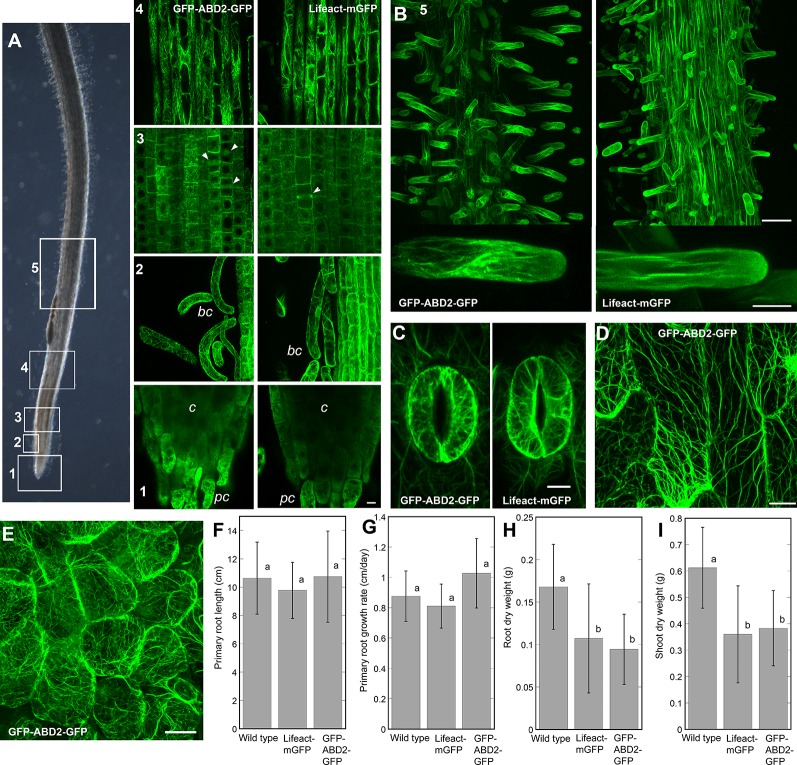
Representative images of F-actin in various cells and tissues of M. truncatula seedlings expressing the UBQ10:GFP-ABD2-GFP and UBQ10:Lifeact-mGFP reporters. (A) F-actin in various developmental regions of seedling primary roots. Numbers (1-5) in (A, B) correspond to regions of the bright field image of the root shown in (panel A). 1 = root cap, 2 = border cells, 3 = meristem 4 = elongation zone, 5 = root hairs. Note that while peripheral cap (pc) and border cells (bc) have distinct F-actin arrays, the columella (c) region has diffuse fluorescent signal. Arrowheads in the root meristem mark the phragmoplasts. (B) Both UBQ10:GFP-ABD2-GFP and UBQ10:Lifeact-mGFP decorate F-actin in growing root hairs. Extensive F-actin networks were also documented in guard cells of cotyledons (C), epidermal cells of minor veins of a young leaf (D) and epidermal cells in a young nodule (E). Scale bars = 10 µm (for A, C, D) 20 µm (for E), 50 µm (for low magnification images in B) and 10 µm (for high magnification images in B). Primary root length and primary root growth rate were not affected in UBQ10:GFP-ABD2-GFP and UBQ10:Lifeact-mGFP lines, compared to wild type (F, G). Actin reporter lines showed smaller root and shoot dry weight when compared to wild type, after 28 days of growth (H, I). Statistical significance was determined by one-way ANOVA. Bars are means (n > 16 plants) ± S.E. Different letters indicate significant differences among means (P < 0.05, Tukey’s test).